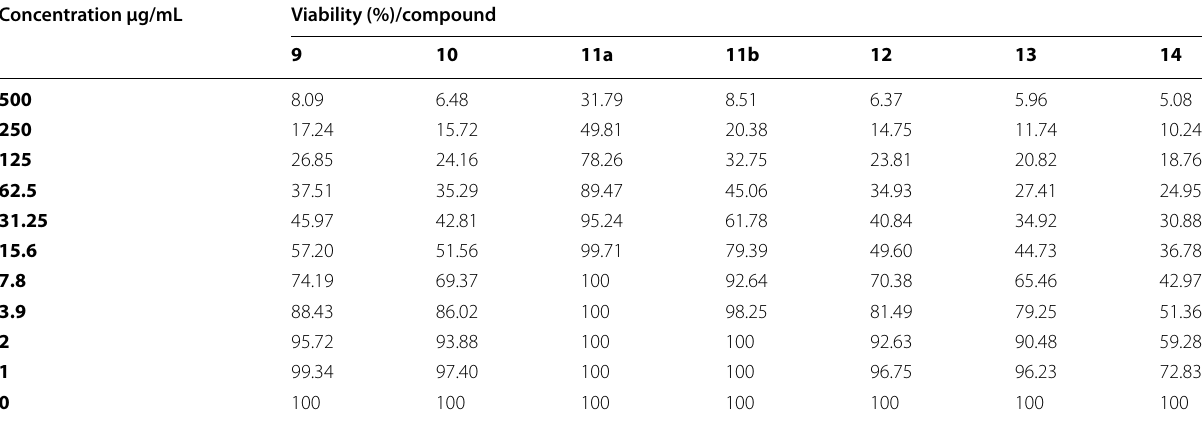
Table 5 Cytotoxicity of compounds 9, 10, 11a, 11b, 12, 13, 14 and 15 against breast carcinoma cell line MCF-7 Concentration µg/mL